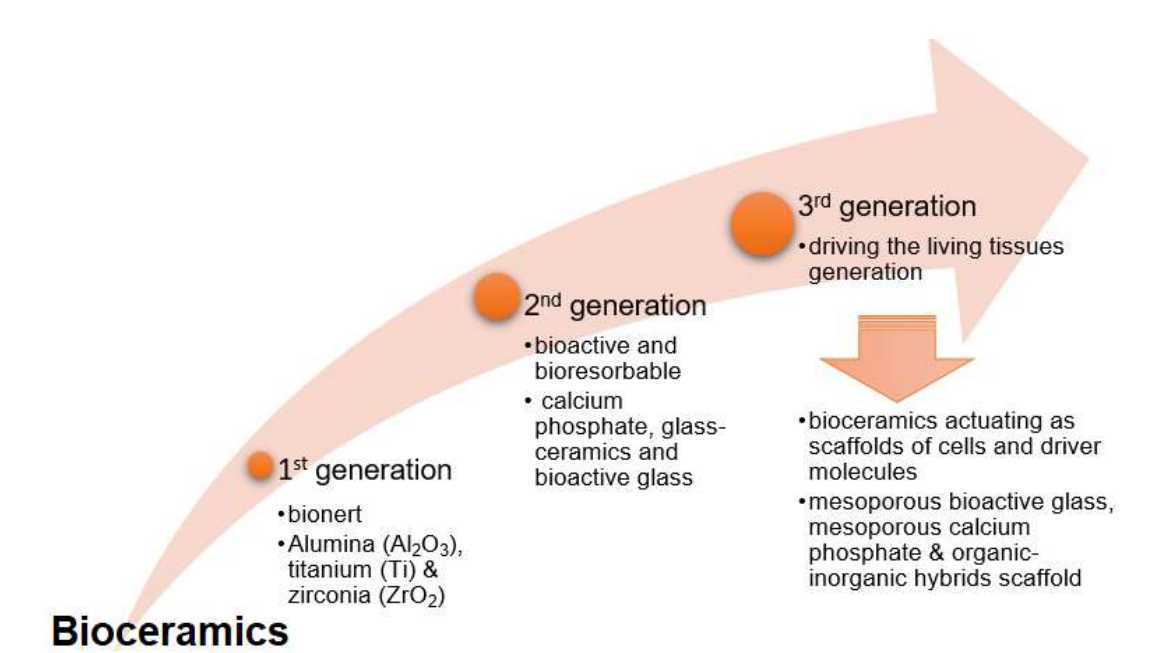
Figure 3. A schematic layout of the three generations of bioceramics [34].